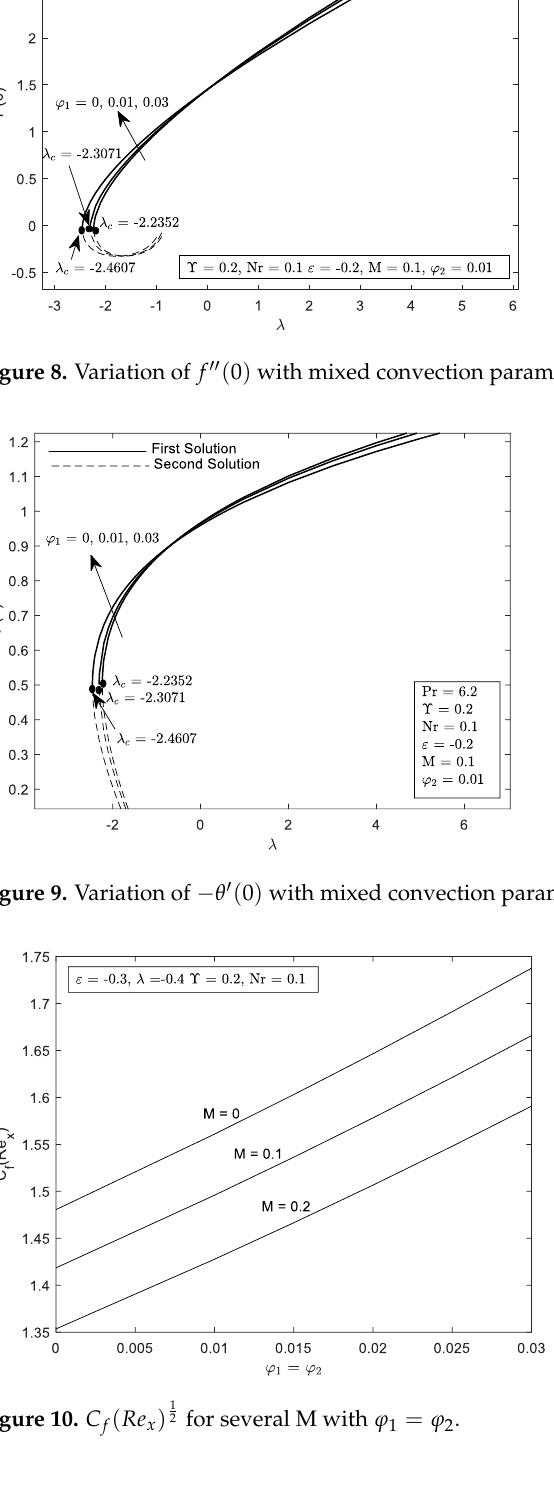
Figure 10. 𝐶 𝒇 (𝑅𝑒 𝒙 )